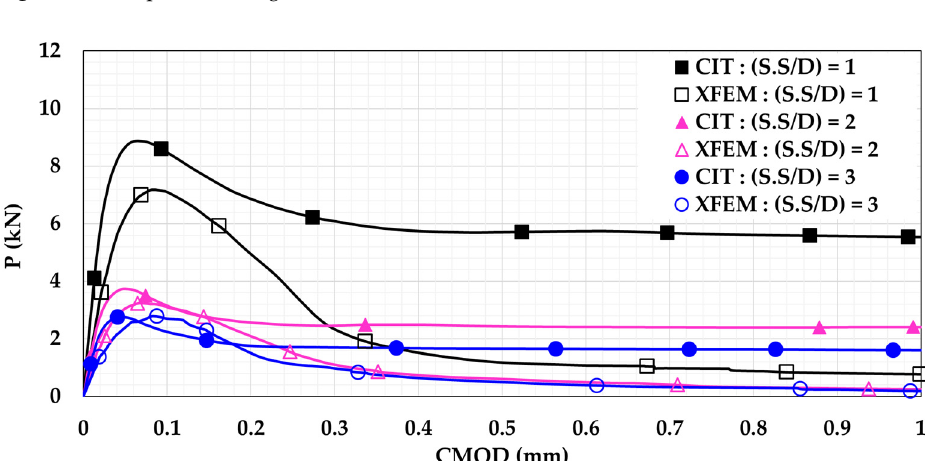
Figure 9. Plain concrete beam P-CMOD relationships for different shear span-to-depth ratios (S.S/D).